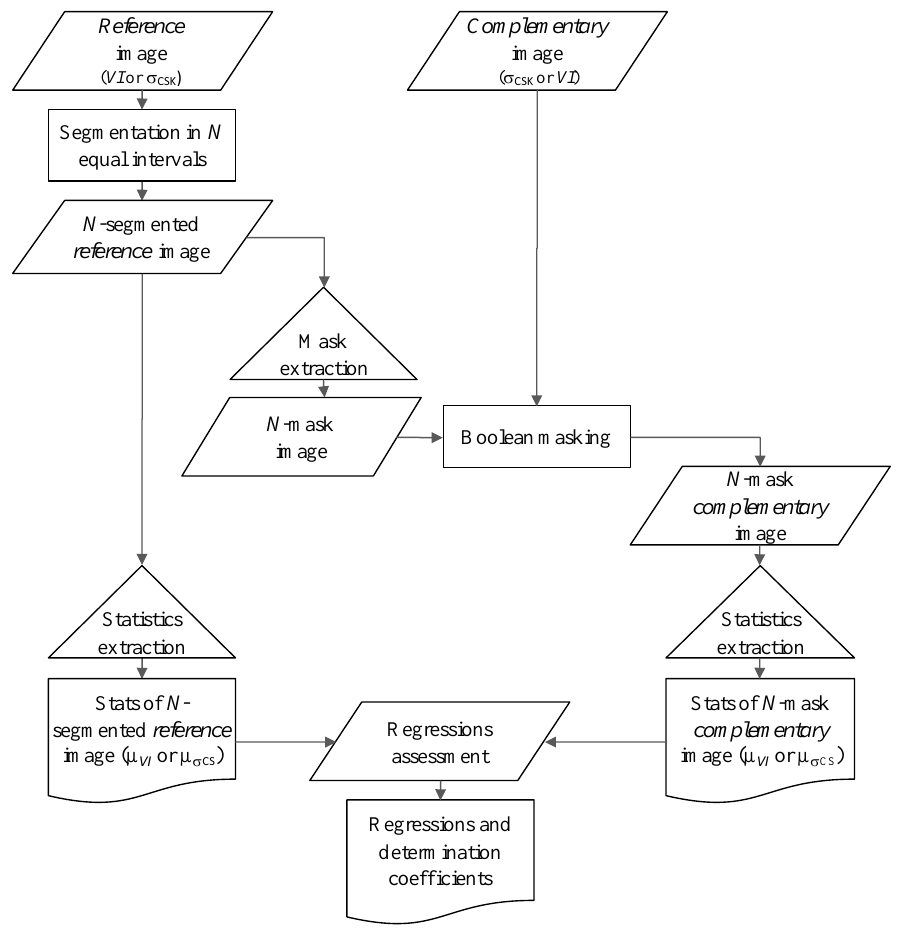
Figure 3.  vs. vegetation index (VI) comparison flow CSK